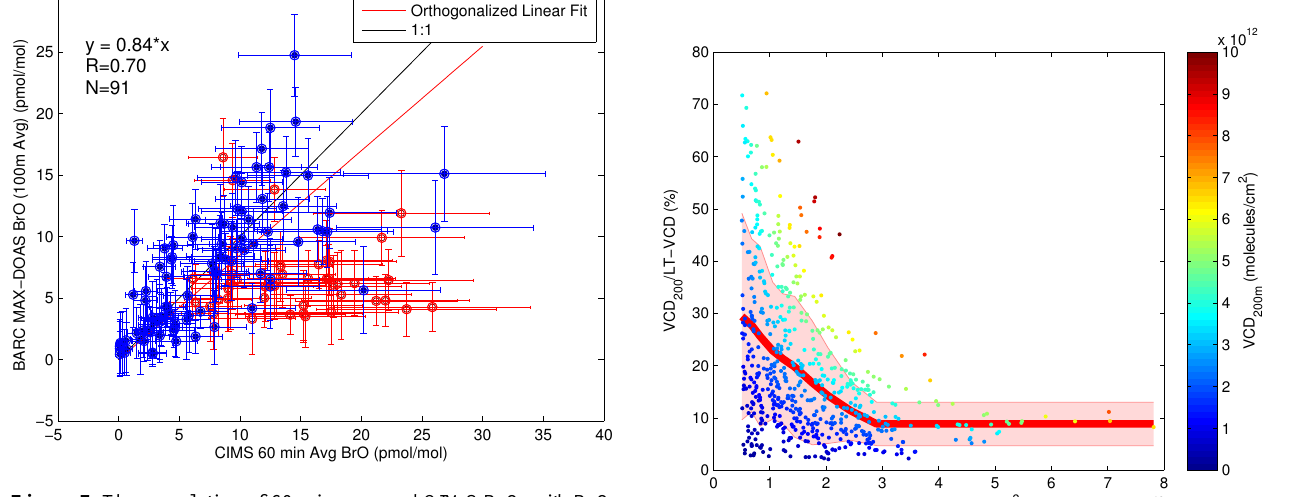
Figure 7. The correlation of 60min averaged CIMS BrO with BrO retrieved in the lowest 100m using MAX-DOAS. Red circles in- dicate times when we observed a chemical gradient between field sites, which are excluded from this correlation.